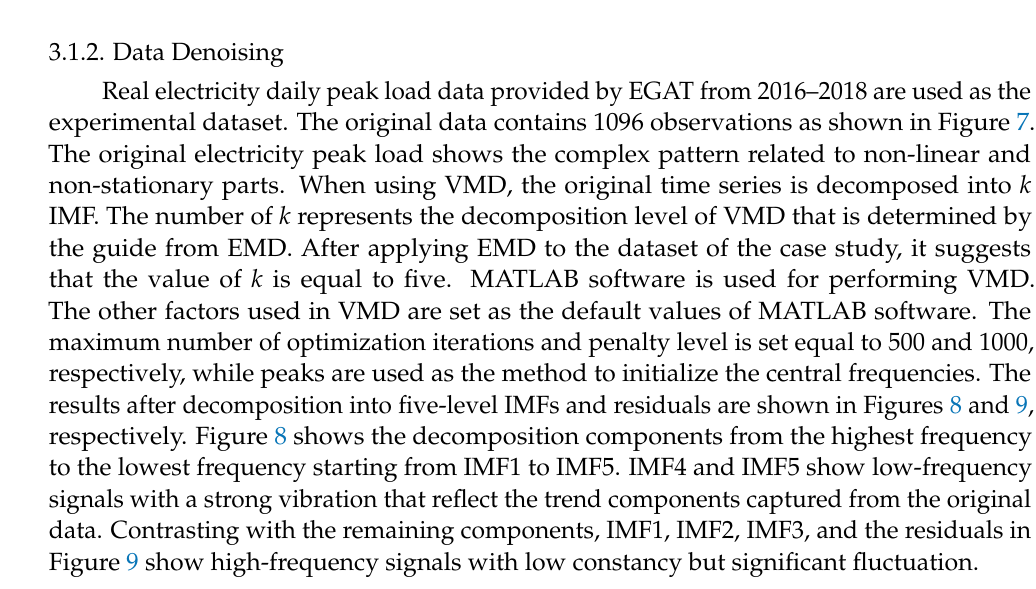
Figure 8. The decomposition result of decomposing peak load into IMF1 – IMF5. Figure 9. The decomposition result of decomposing peak load into residuals. 3.1.3. Seasonality and Trend Capturing To capture the seasonality and trend components, FFT is applied to all IMFs and re- siduals. The resulting seasonality and trend components after applying FFT are clearer to identify and easier to capture, as shown in Figure 10.